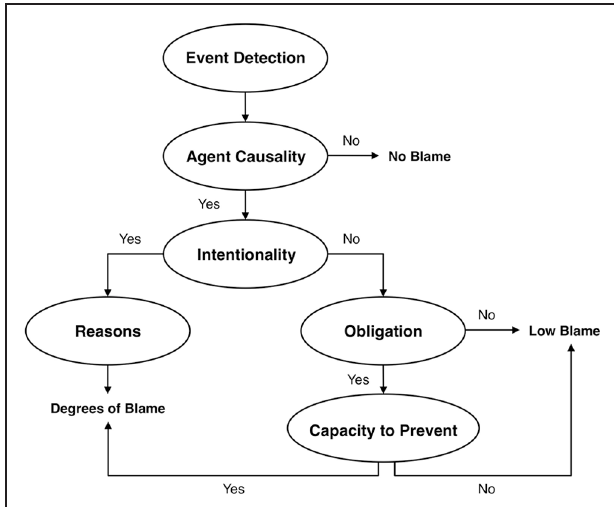
FIGURE 6 | Malle et al.’s Path Model of Blame. Reprinted from Malle et al. (2014) with permission from Taylor and Francis